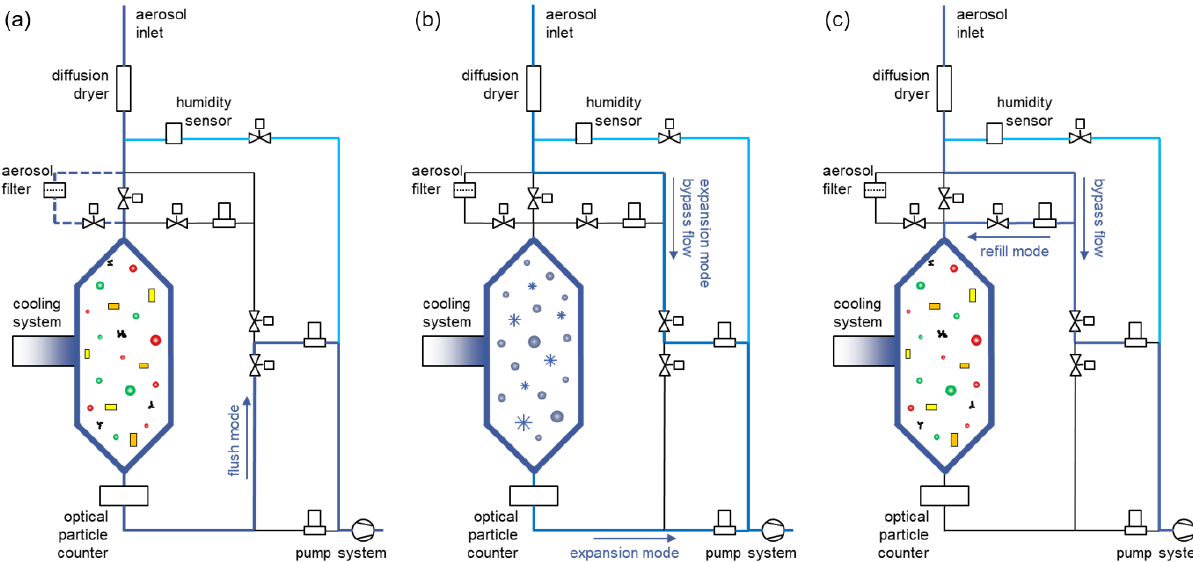
Figure 2. Schematic setup of the PINE. The three figures show the same instrument but in the different run modes (a) flush, (b) expansion and (c) refill. The thick blue lines indicate which parts of the flow setup are active in the respective modes. The sampling gas flow through the humidity sensor (light blue line) is active all the time in a bypass line to the sampling pump. A background measurement can be done by passing the sample flow over an aerosol filter (dashed line, a ). In the flush mode (a) , aerosol particles are sampled (coloured various symbols) and activate into cloud droplets and ice crystals during the expansion mode ( b , blue circles and stars, respectively). During the refill mode, aerosol particles enter the chamber again ( c , coloured various symbols). Table 1. Configuration and operational parameters of PINE prototype version 1A as well as the currently available commercial version PINE-c. PINE-1A